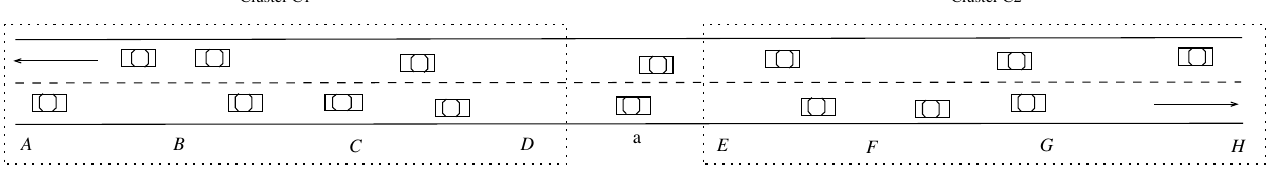
Figure 5. Illustrating clustering and fault tolerance in